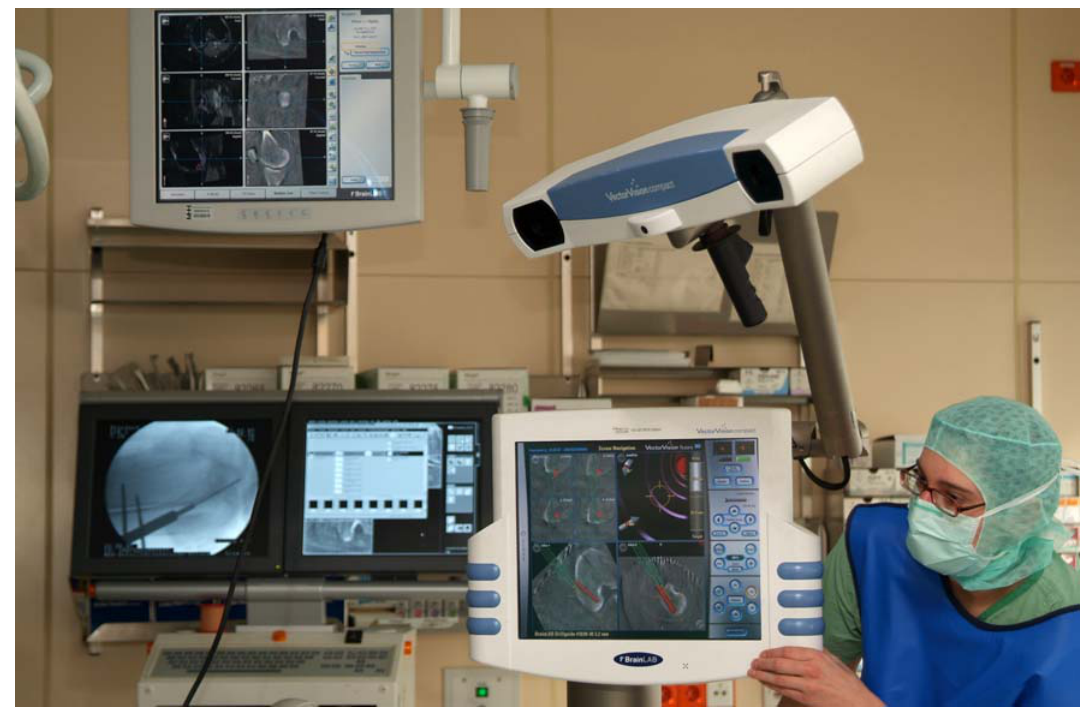
Fig. 3 Navigation screen during the 3-D fluoroscopic drilling. Shown are a conventional fluoroscopic image and a secondary ceiling-mounted flat panel monitor. The nurse can easily use the touch-screen